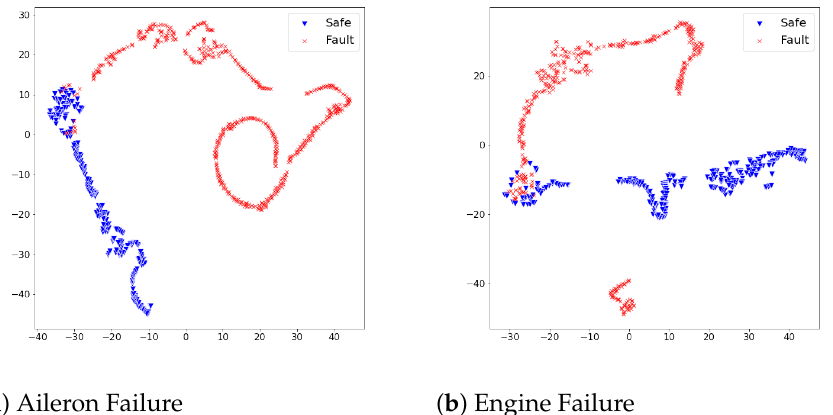
Figure 6. The distribution of dimensionality-reduced feature vectors from the safe states and faulty states vary on the 2D space. The duplicated area consists of feature vectors from safe states and faulty states imply that the fault detection model would confuse the identification of faulty states from safe states. We analyzed this adjoined distribution between two states hampered our approach to accomplish a promising detection